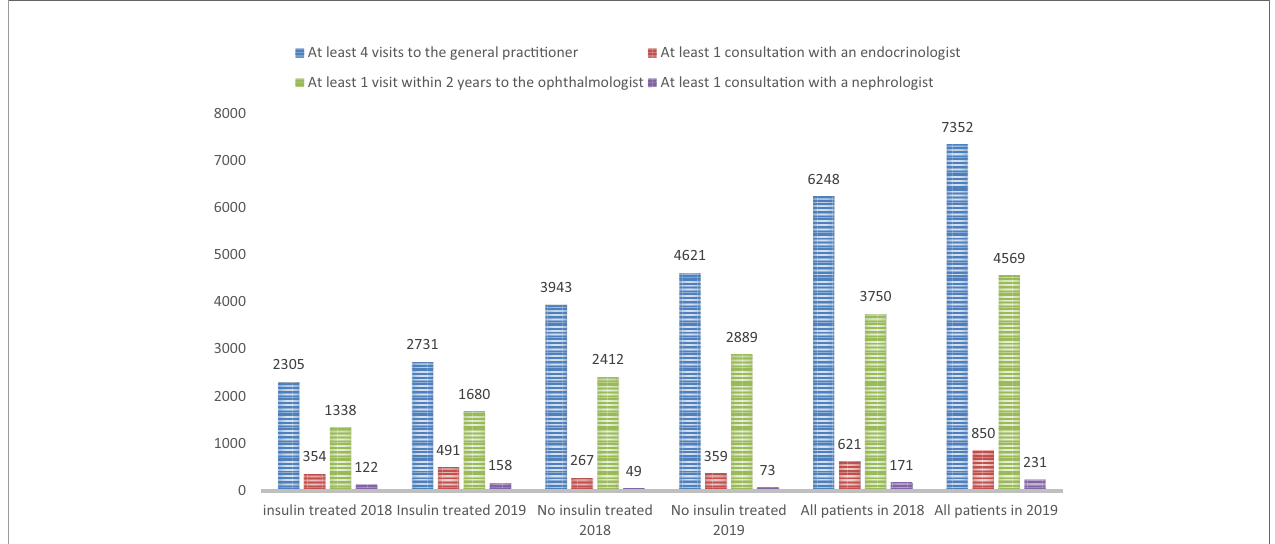
FIGURE 5 | Distribution of medical visits recommended by the guidelines.